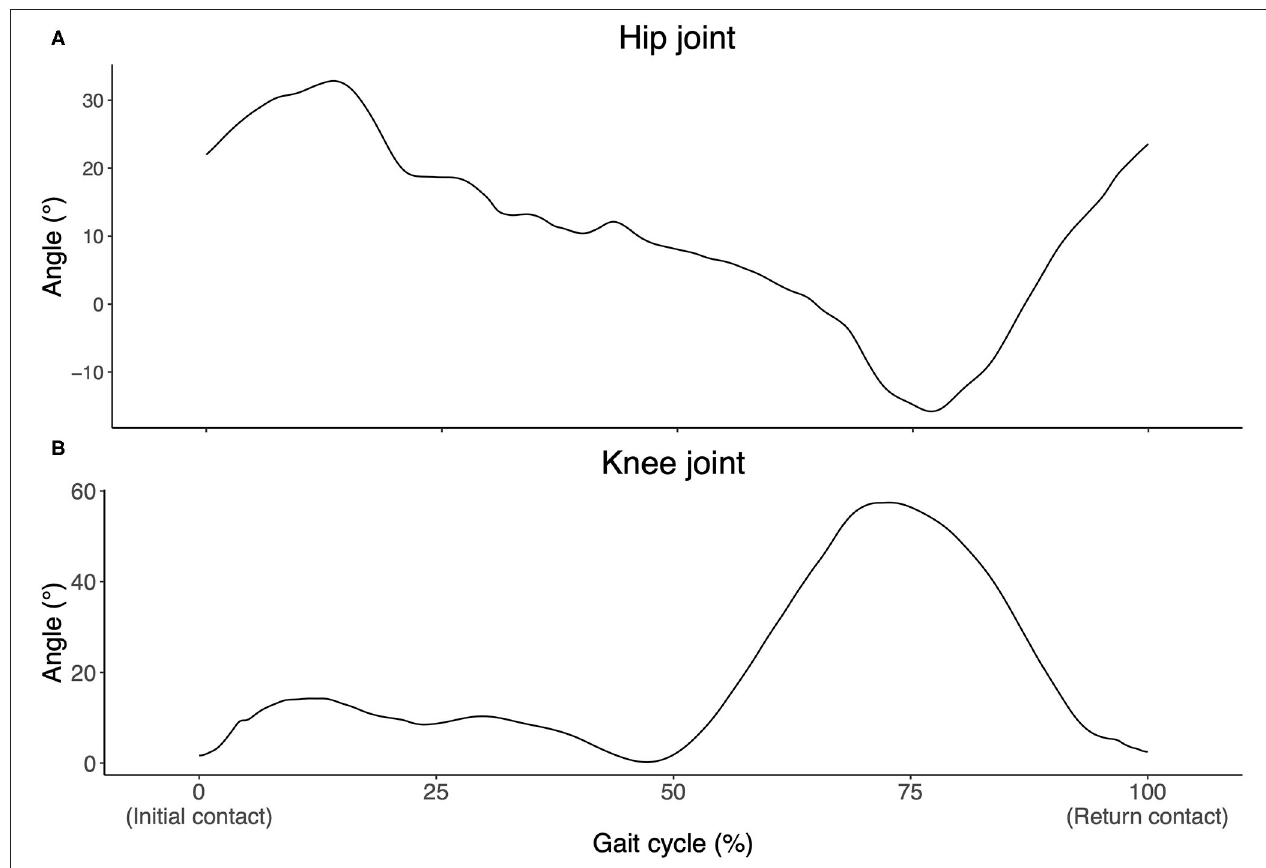
FIGURE 4 | Hip (A) and knee (B) joint angle exemplar data for a single gait cycle of the yoke walk. Flexion denoted by a positive angle and extension denoted by a negative